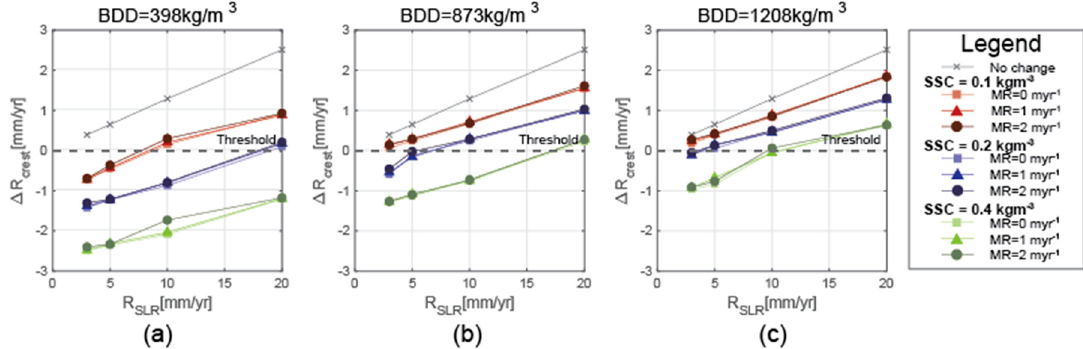
Figure 3. The year-averaged dike heightening rate ( Δ R crest ) on top of sea-level rise ( R SLR ) for the Dollard in the Dutch Wadden sea. The grey line represents a static foreshore without any morphological changes. The coloured lines represent sediment concentrations. The marsh retreat rate scenarios are denoted by the symbols and variations in shade of colour. The dashed black line at ∆ R crest = 0 is the threshold, above which the year-averaged rate of dike reinforcement exceeds the anticipated rate of sea-level rise.